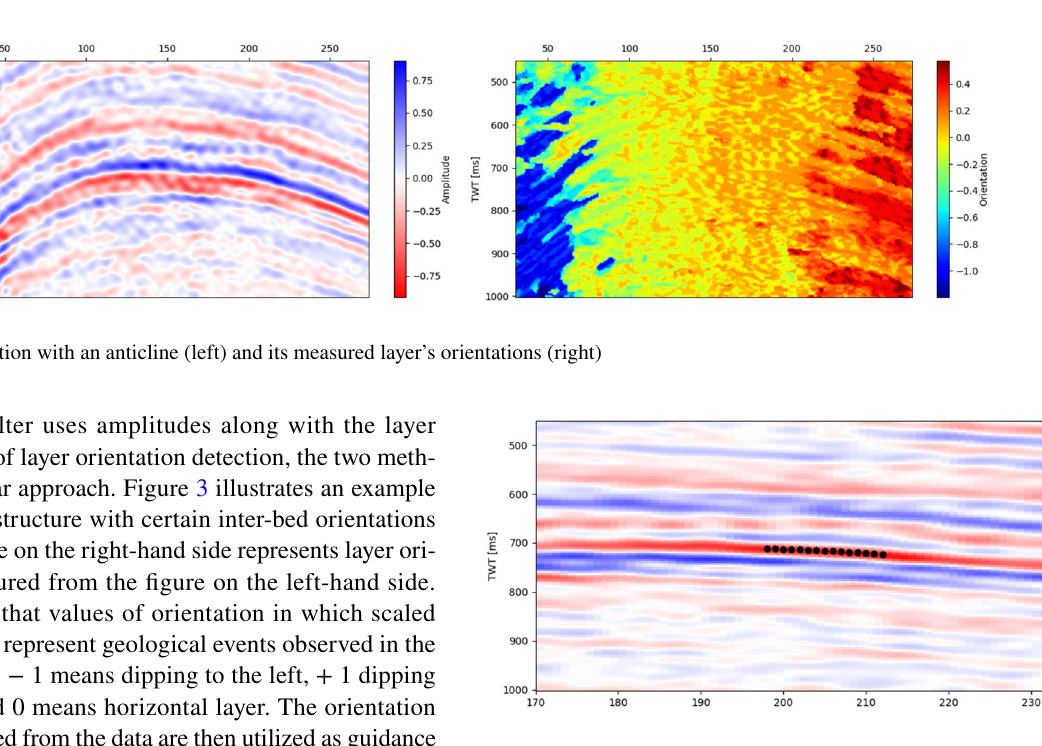
Fig. 2 Section of seismic layers with different dips (left) and its spectrum F − K domain (right)